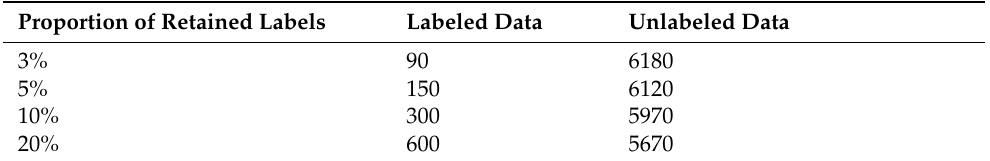
Table 2. Composition of the training